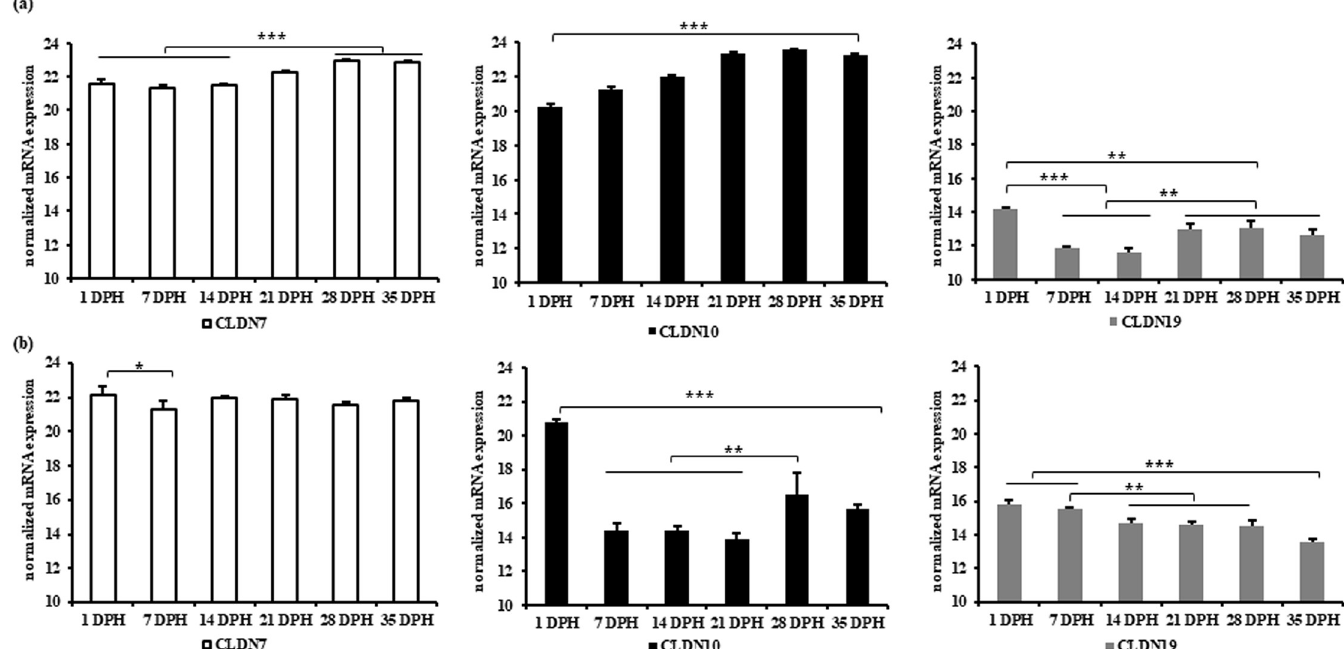
Fig 6. Normalized mRNA expression of pore-forming or ambiguous claudins in (a) jejunum and (b) caecum at different age of broiler chickens. Results are presented as means with SEM (n = 5 birds). Statistical analysis was performed using ANOVA and Duncan’s test, � = P � 0.05, �� = P � 0.01, ��� = P � 0.001. Horizontal lines above the bars indicate no significance.